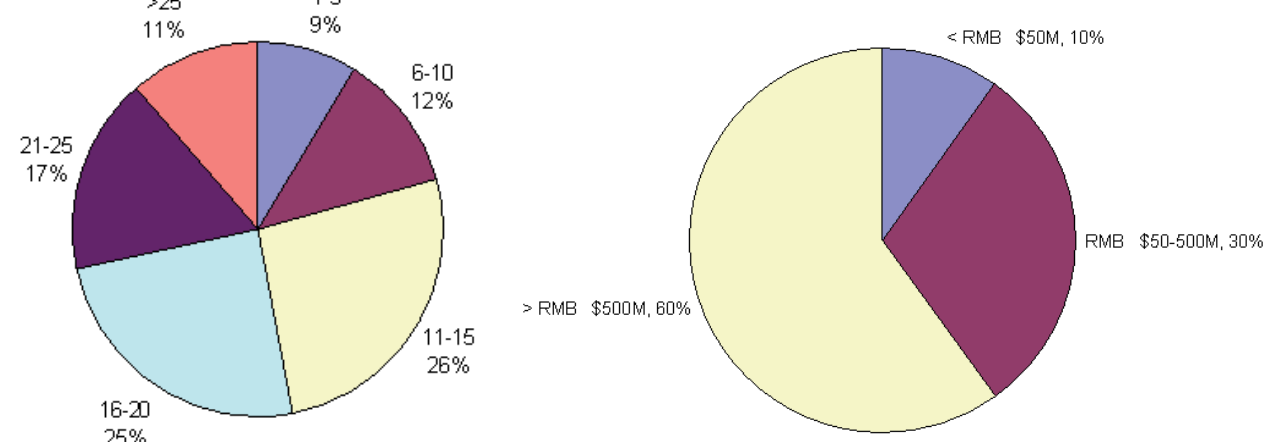
Figure 3: Value of projects